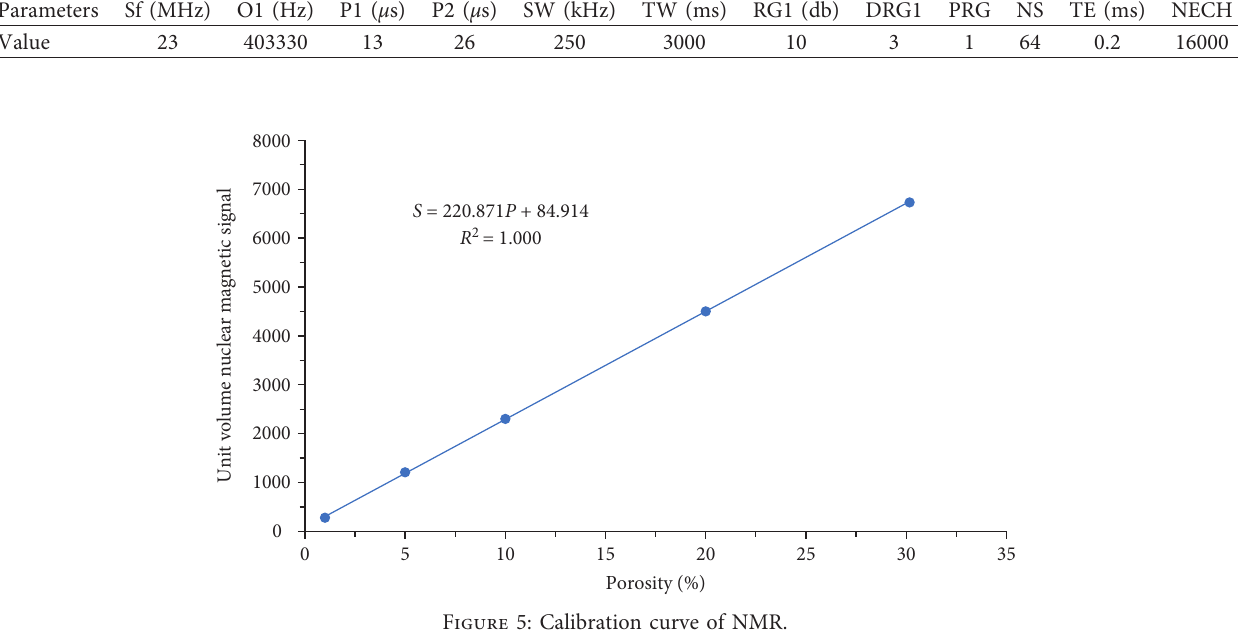
Figure 5: Calibration curve of NMR.